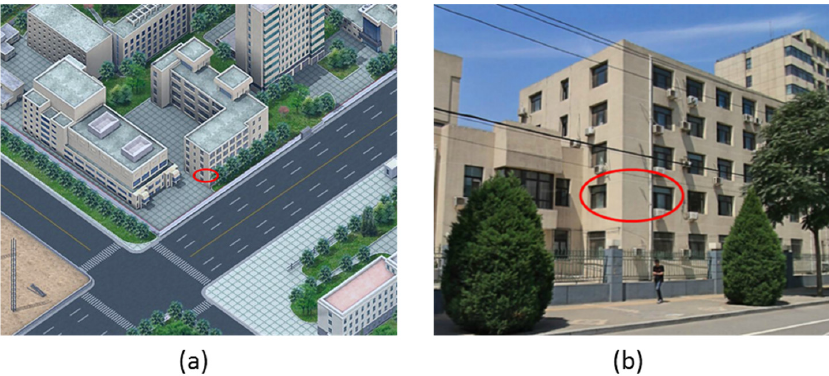
Figure 2. Aerial view ( a ) and outdoor view ( b ) of the measured room.